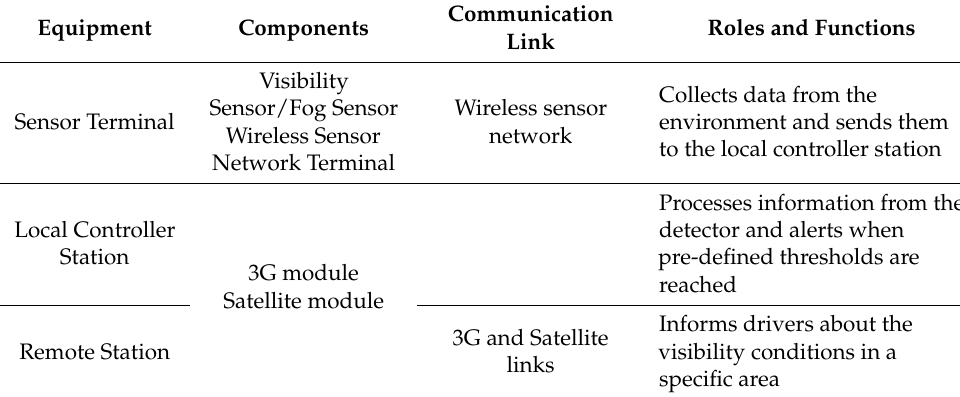
Table 6. Fog detection and warning system setup presented in